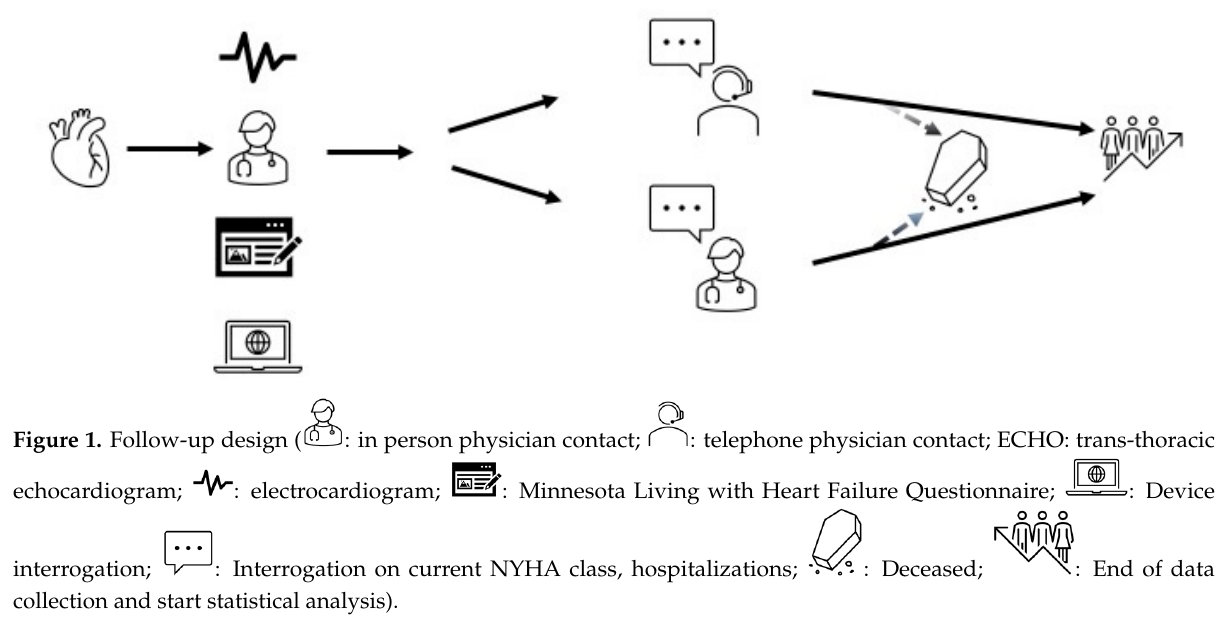
Figure 1. Follow-up design (